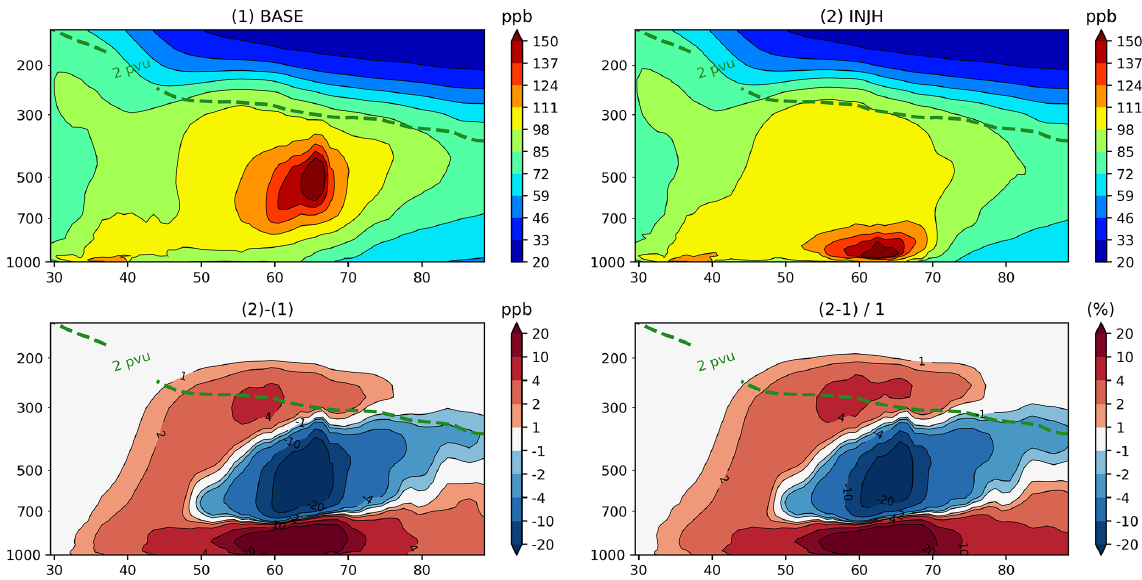
Figure 10. Zonal mean of CO mixing ratios for the month of August 2013. The mean is calculated between 30–90 ◦ N and 30–180 ◦ E. The dotted green line indicates the 2 PVU